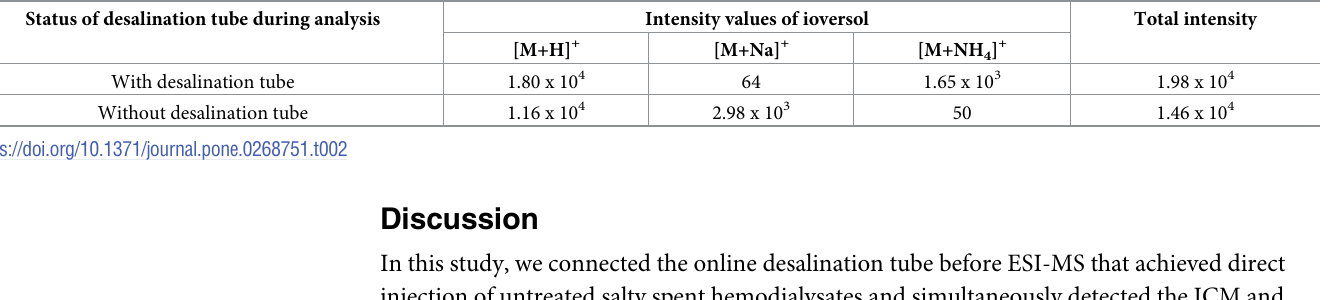
In this study, we connected the online desalination tube before ESI-MS that achieved direct injection of untreated salty spent hemodialysates and simultaneously detected the ICM and endogenous metabolites. Previously, our group developed this desalination tube and showed